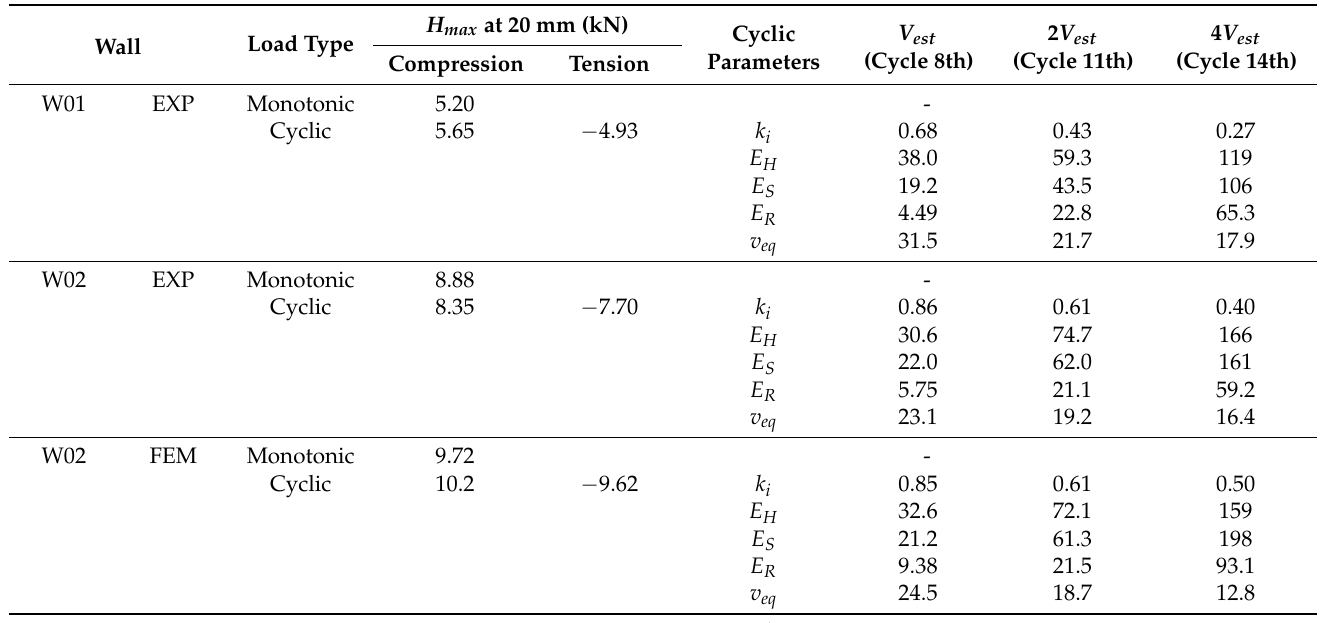
Table 1. Experimental and numerical hysteretic parameters for specimens W01 and W02, and FEM